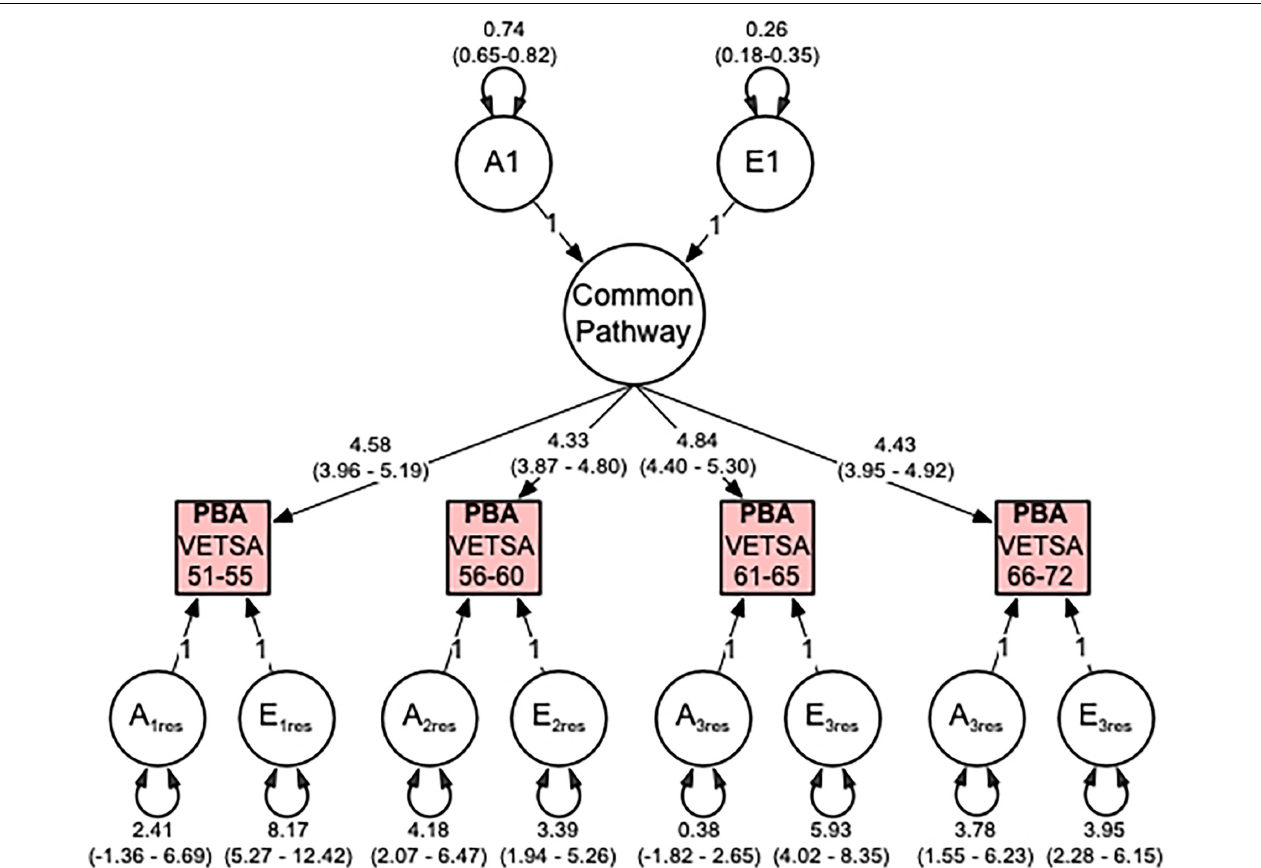
FIGURE 3 | Predicted brain age (PBA) best fitting common pathway (CP) multivariate model comprising additive genetic (A) and non-shared environment (E) variance components. Illustrated are the genetic and environmental variance components for the common pathway, the factor loadings from the CP to the observed PBA phenotypes, and the genetic and environmental residual variance components. All variance components are standardized and include 95% confidence